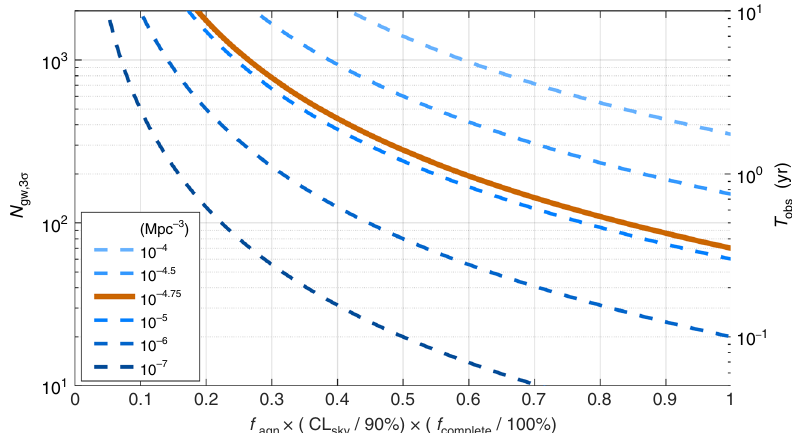
Fig. 1 Number of gravitational-wave detection required for host identi fi cation. Number of detections ( N gw,3 σ ) needed to establish active galactic nuclei (AGN) as host population at a median 3 σ signi fi cance, as a function of the fraction ( f agn ) of gravitational-wave (GW) detections originating from AGN. The results are shown for different assumed AGN number densities (see legend), with fi ducial density ρ agn = 10 − 4.75 Mpc − 3 23, 24 , for the Advanced Laser Interferometer Gravitational-wave Observatory (LIGO)-Virgo network at design sensitivity. On the right hand side axis, we mark the necessary observation duration corresponding to numbers of detection, assuming 200 detections per year. We also indicated in the label of the x axis the results ’ scaling with the sky volume credible level used (CL sky ) and host catalog completeness ( f complete